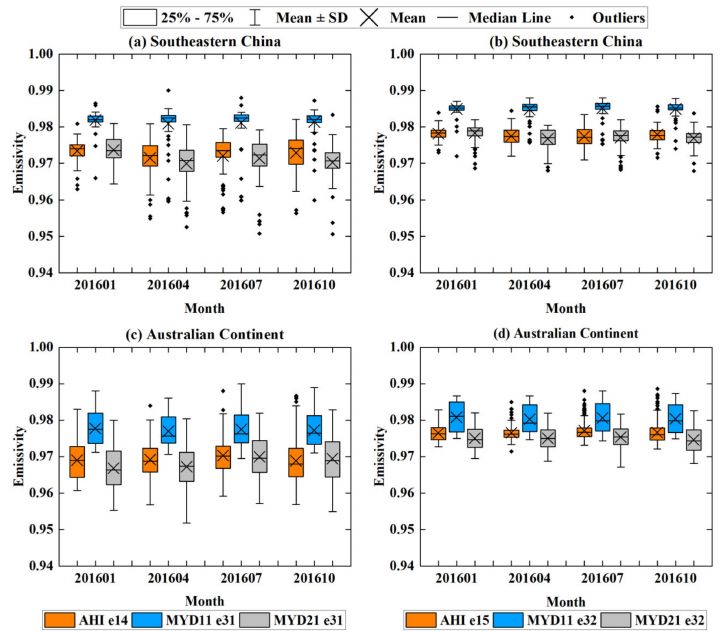
Figure 8. Nighttime emissivity values of AHI in bands 14 and 15 and of MYD11 and MYD21 in bands 31 and 32 over the two study areas. ( a , b ) Southeastern China results and ( c , d ) Australian continent